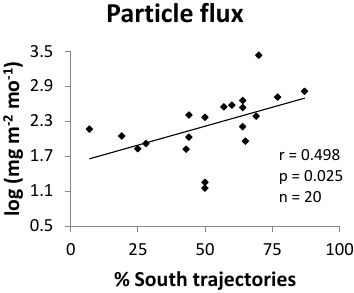
Fig. 7. Relationship between particle deposition fluxes and air mass trajectories flowing from the south in Redon.